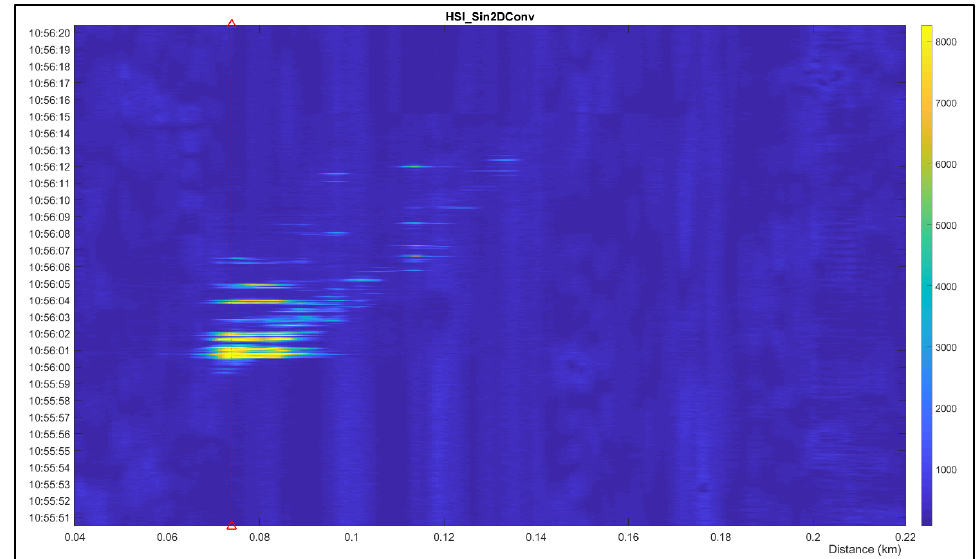
Figure 13. 2D sinusoidal convolution applied to DAS data of train running over two stones. Signal is observed at the position of the stones (red triangles).